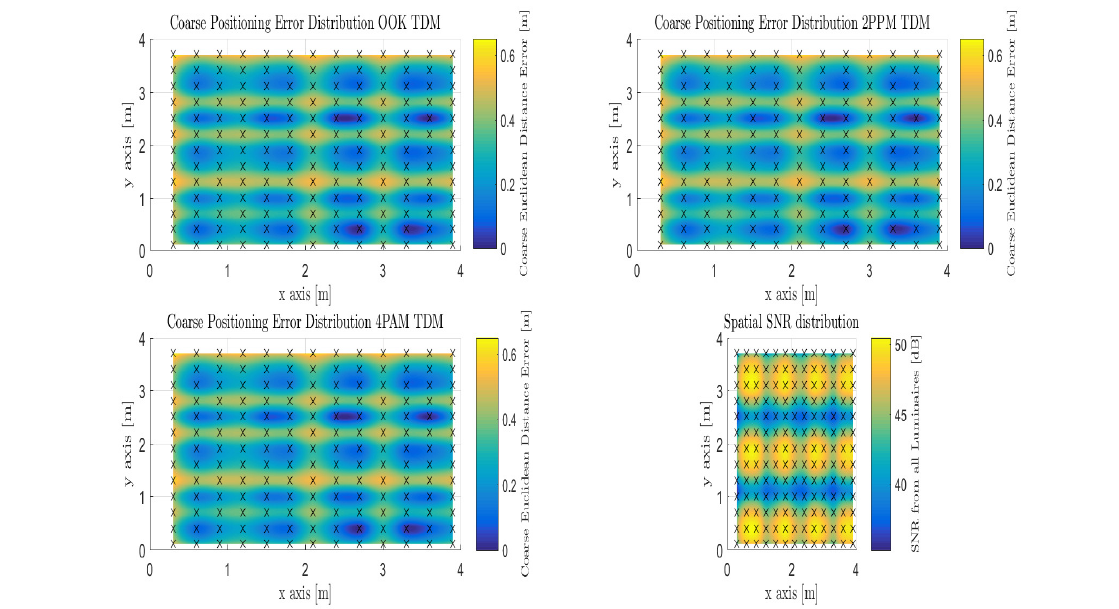
Figure 8. Illustration of Coarse Proximity-based Positioning with Time Division Multiplexing for OOK, 2-PPM, and 4-PAM pulsed modulations under the Spatial SNR Room